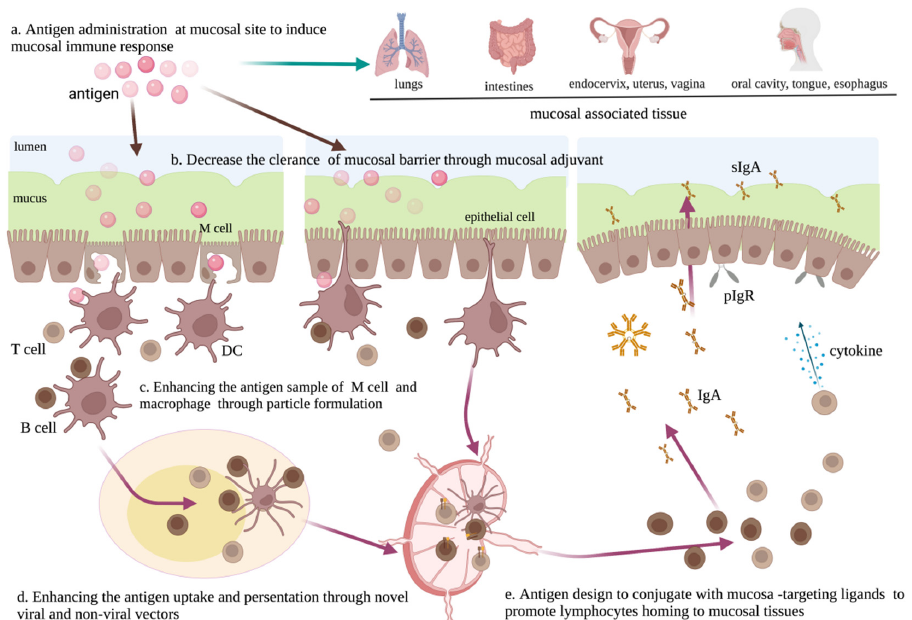
Figure 2. Challenges and solutions for the development of mucosa-targeting vaccines. ( a ) Antigen administration through mucosal route (such as aerosol inhalation, rectum, vagina, and oral administration) can effectively induce mucosal responses through mimicking the natural infection of pathogens. ( b ) Antigen administration along with mucosal adjuvants can enhance the mucosal immune response through avoiding the adverse effect of the mucosal barrier. ( c ) Encapsulating the vaccine into a nanoparticle formulation can enhance mucosal responses because M cells and DC cells preferentially sample particle antigens from the lumen. ( d ) The use of novel vaccine-delivery vectors, including viral and non-viral vectors, can effectively promote antigen uptake and presentation, and thus enhance mucosal responses. ( e ) Antigens conjugated with mucosa-targeting ligands can induce mucosal responses through homing to the mucosal